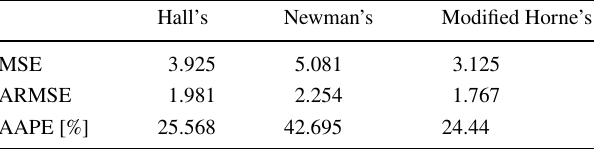
Fig. 1 Core laboratory-derived compressibility values for Iranian, Asmari carbonate, compared with industry, empiri- cal correlations: Hall (1953), Newman (1973) and modified Horne (Jalalh 2006)